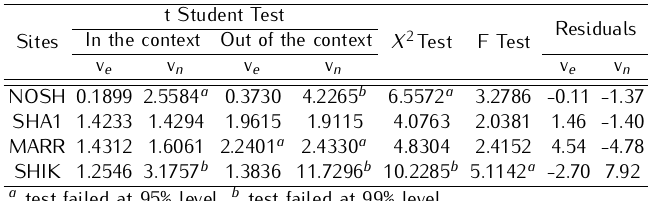
Table 8. Tests results (block B9). The results of the statistical tests for the GPS site data components. The sites passed from all the tests are the accepted data. The tests have been performed in two confidence levels (95% and 99%).